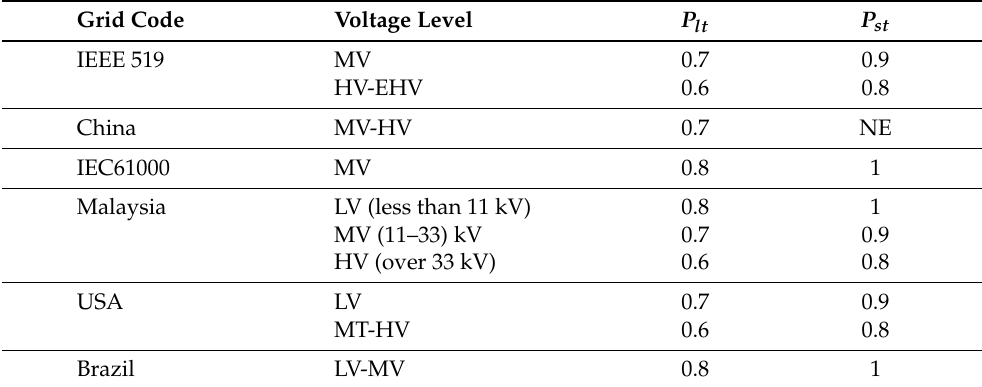
Table 8. Flicker limits according to different standards at different voltage